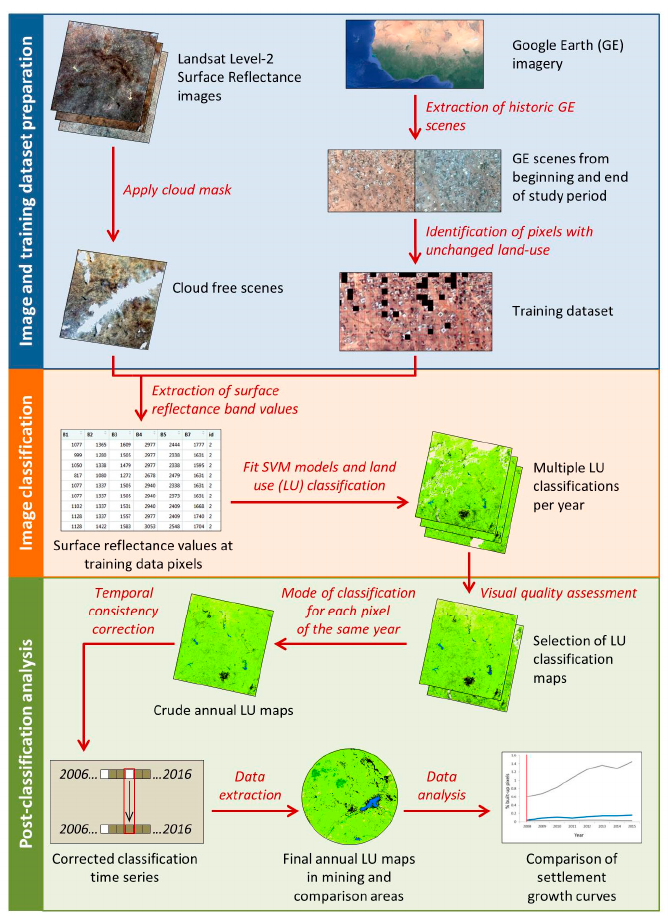
Figure 2. Data sources and methodological flowchart. GE: Google Earth. SVM: support vector machine. LU: land